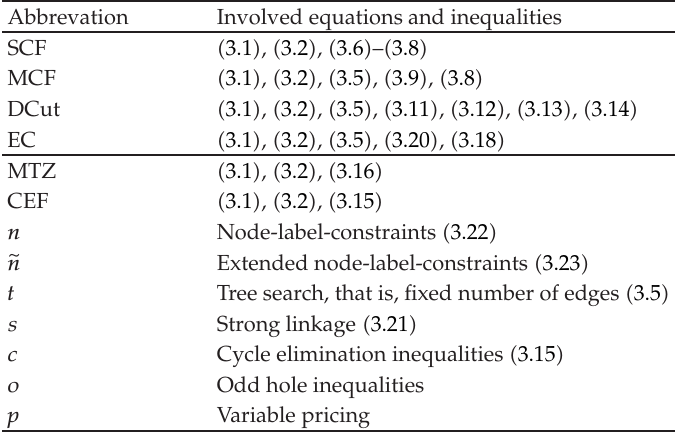
Table 1: MLST formulations resulting from combining the equations and inequalities from Section 3. Further variants are given by the use of the components listed in the second part of the table, to be used as index for the formulation to be used